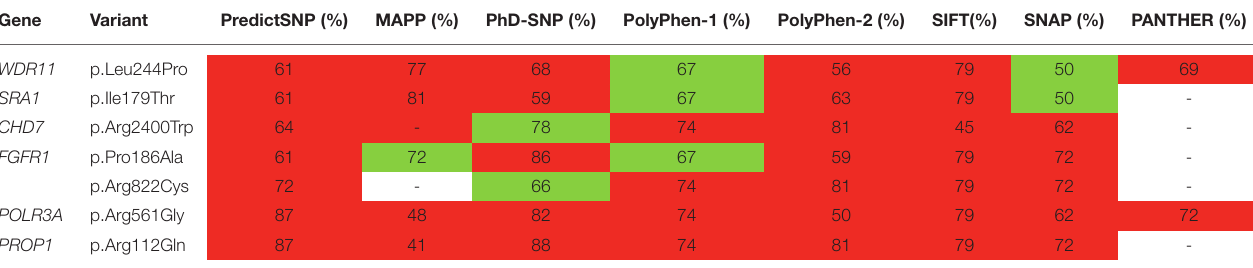
TABLE 3 | Prediction analysis of the variants identified. Gene Variant PredictSNP (%) MAPP (%) PhD-SNP (%) PolyPhen-1 (%) PolyPhen-2